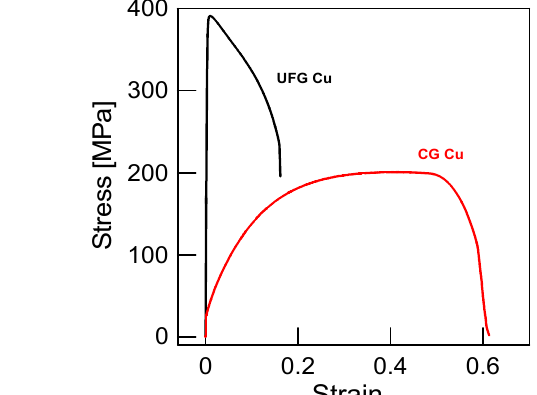
Figure 5: Comparison of tensile diagrams of UFG and CG